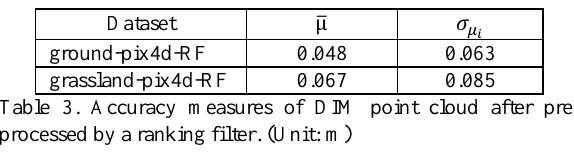
Figure 9. Distribution of deviation between DIM-RF and DIM- raw. Top: paved ground; Bottom: